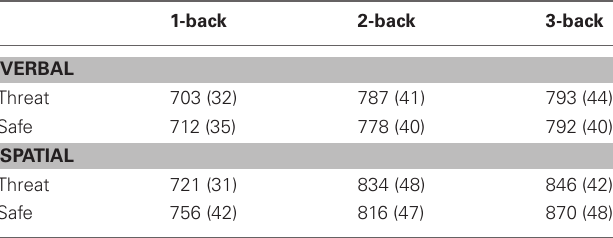
Table 1 | Mean reaction time for verbal and spatial working memory as a function of experimental condition and cognitive load.